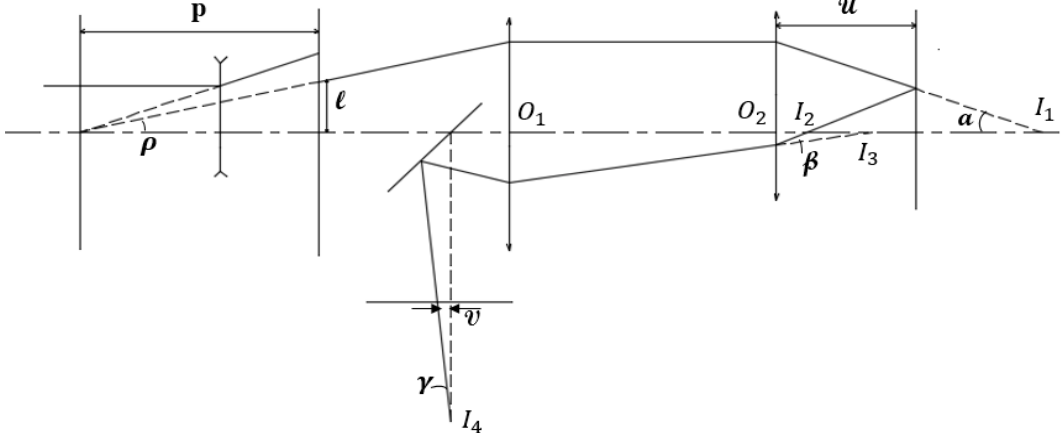
Figure 3. Geometrical optics of the setup.